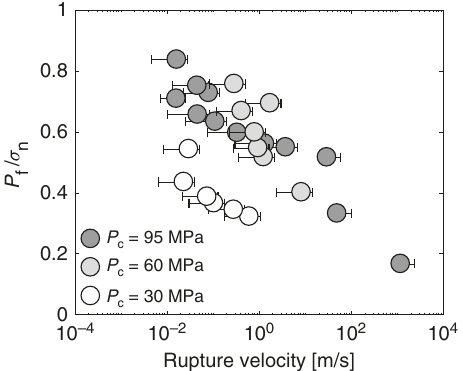
Fig. 5 In fl uence of the ratio between the fl uid pressure and the normal stress acting on the fault at the onset of fault slip on rupture velocity. For each con fi ning pressure, the larger the ratio lambda, the smaller the stress drop and the smaller the rupture velocity during